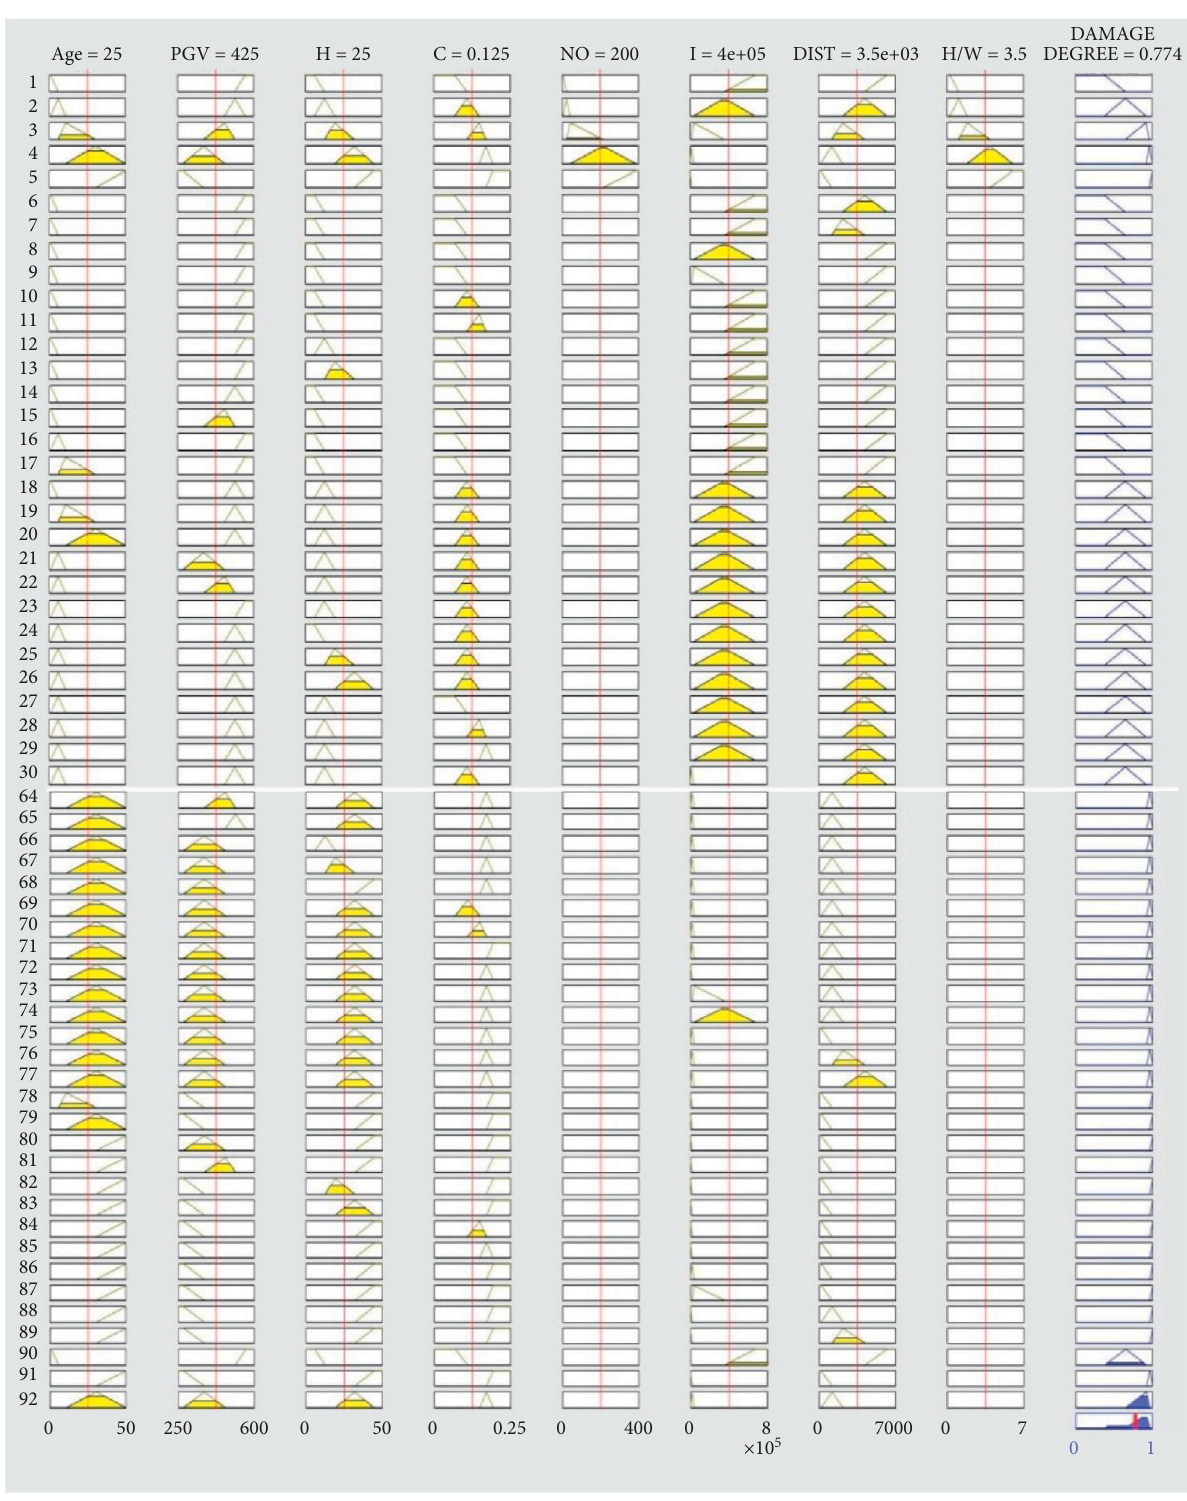
Figure 5: A fuzzy model for predicting the degree of damage to a building after an